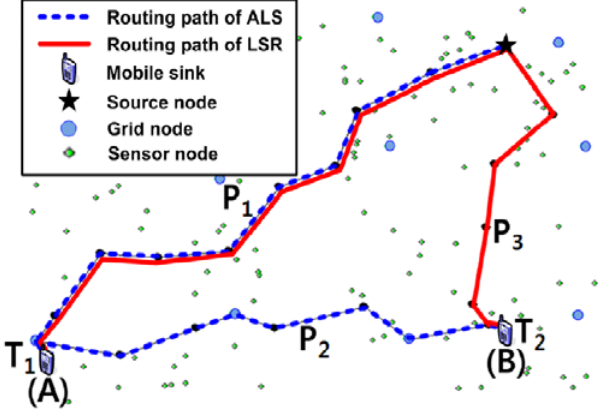
Figure 5. An example of the comparison of ALS and LSR to support sink mobility and data forwarding (extracted result from the simulator). Routing path of ALS and LSR = P 1 (same) on point A , Routing path of ALS = P 1 + P 2 and LSR = P 3 on point B .